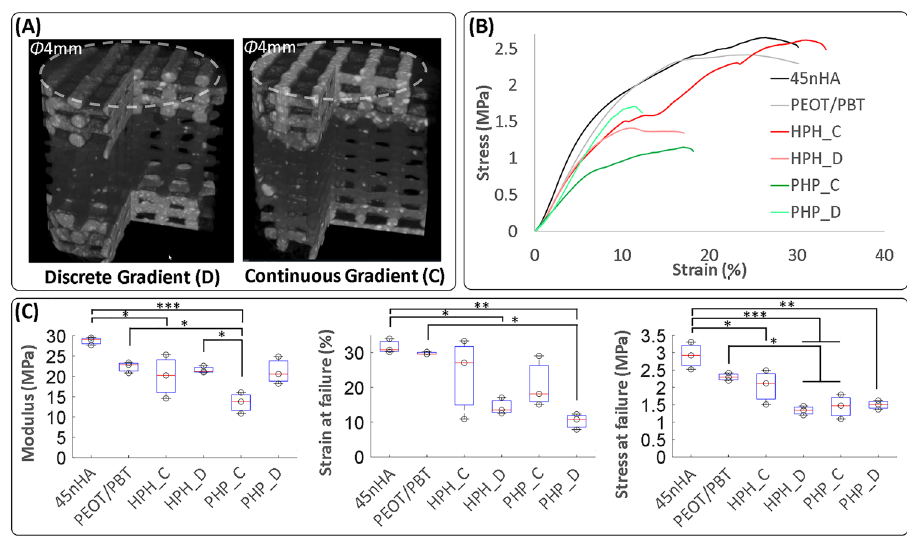
Fig. 4 Printing of gradient scaffolds using the developed printhead demonstrated an improvement in the mechanical properties of continuous vs. discrete composition gradients. Mechanical test samples were imaged using micro-computed tomography ( µ CT) to demonstrate the differences in fi ller distribution between the discrete and continuous gradients ( A ). Uniaxial uncon fi ned compression tests were performed and the comparison of stress – strain curves demonstrated the variations in load-bearing behavior of the various scaffolds ( B ). From the stress – strain curves, the elastic modulus, the strain and stress at failure were computed, and demonstrated that continuous gradients withstood higher strains before failure ( C ). Box and whisker plots show median, upper, and lower quartiles as boxes, and minima and maxima marked by whiskers for three distinct scaffold replicates, individual datapoints are overlaid, and signi fi cant differences are marked as * p < 0.05, ** p < 0.01, and *** p <